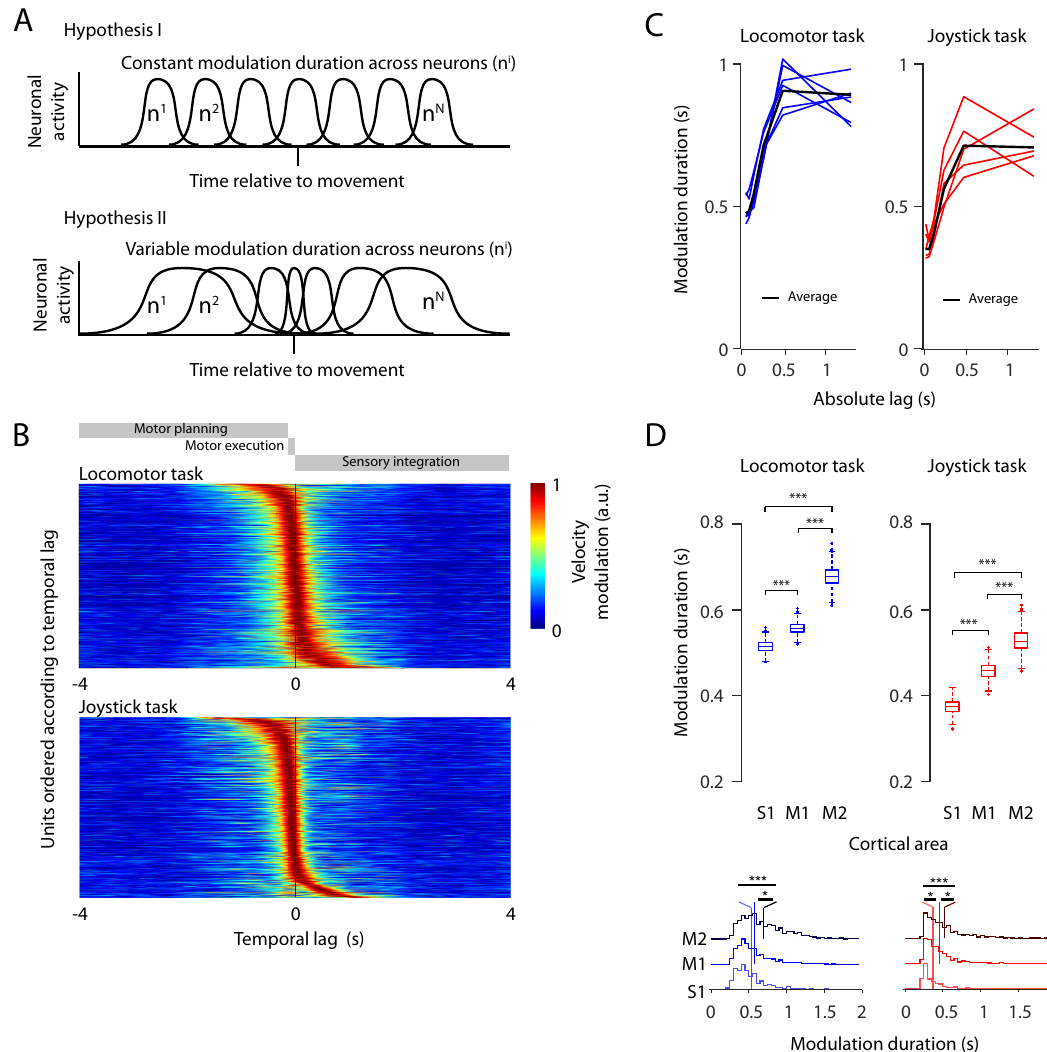
Fig. 2 The duration of velocity modulation of individual units depends on the temporal lag to behavior and on the cortical area. A Two hypotheses of sequential neuronal activity relative to movement. The duration of the neuronal activity can be constant across lags (upper panel) or different across lags (lower panel). B Units sorted according to the lag of their maximum velocity modulation in the locomotor task (top), and for the joystick task (bottom). C Relationship between average modulation duration and temporal lag (black line), across the different animals (colored lines) for the locomotor (left) and joystick task (right). D Top panel: Duration of the velocity modulation for each cortical area for the locomotor task (left) and the joystick task (right). Two- sided non-paired t -test corrected for dependence (see methods). Locomotor task: S1 ( n = 1766), M1 ( n = 2450), M2 ( n = 1197), M1-M2: p = 1.7e-35, S1- M2: p = 3.7e-53, S1-M1: p = 1.3e-9. Joystick task: S1 ( n = 837), M1 ( n = 1015), M2 ( n = 759), M1-M2: p = 3.9e-9, S1-M2: p = 2.1e-31, S1-M1: p = 2.8e-17. The data for each box-plot is bootstrapped and corrected for dependence across sessions (see methods). Box-plots: central mark indicates the median, bottom and top edges refer to the 25th and 75th percentiles. Primary sensory cortex (S1), primary motor cortex (M1), and secondary motor cortex (M2). Bottom panel: Histograms of the modulation duration for each cortical area for the locomotor task (left) and the joystick task (right). A mixed-effect model was used to calculate signi fi cances between the cortical areas. Mixed-effect model (see methods): Locomotor task: M1-M2: p = 2.2e-6, S1-M2: p = 4.0e-5, S1-M1: p = 0.23. Joystick task: M1-M2: p = 0.0142, S1-M2: p = 6.2e-5, S1-M1: p = 0.016. Signi fi cances are indicated according to * p < 0.05, ** p < 0.01, and *** p < 0.001. Source data are provided as a Source Data fi